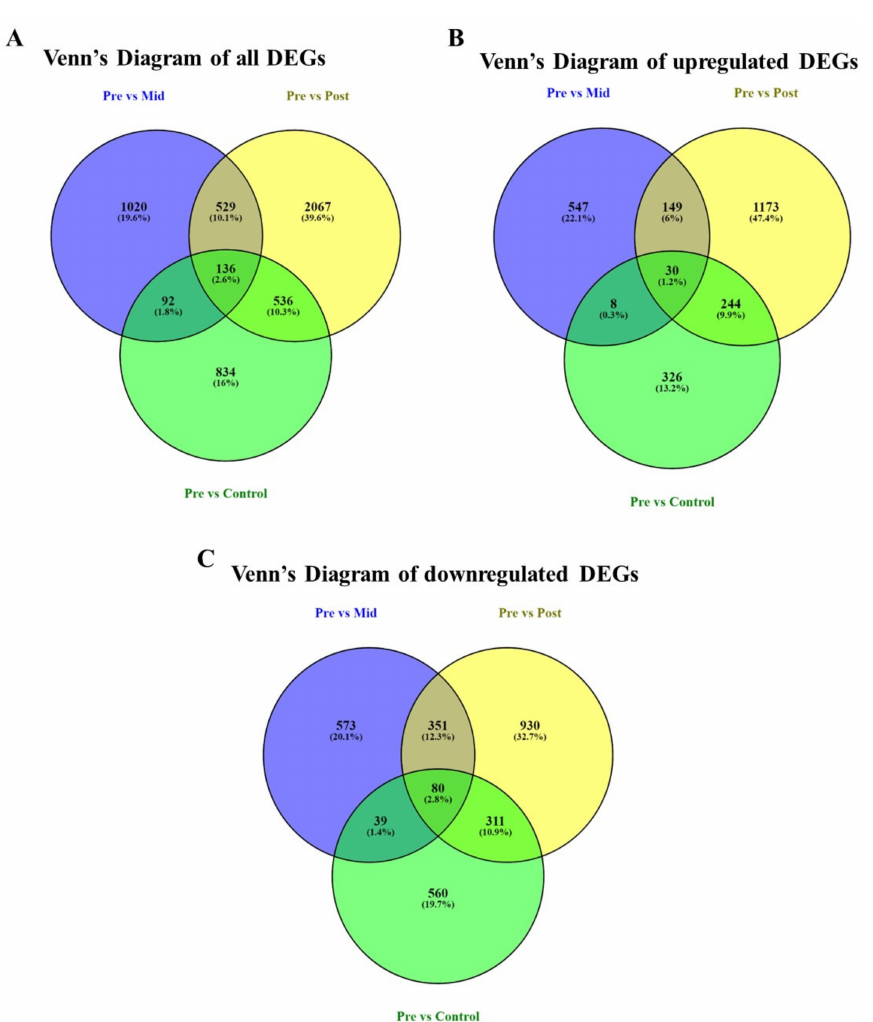
Figure 1. Distribution of differentially expressed genes (DEGs) in the stem of O. javanica under blanching treatment. Pre-blanched plants are the reference point for all analyzed samples: mid- blanched, post-blanched plants, and control samples. Blue color represents ‘pre vs. mid-blanching’, yellow represents ‘pre vs. post-blanching’, and green represents ‘pre vs. control’ samples. ( A ) All DEGs, ( B ) upregulated DEGs, and ( C ) downregulated